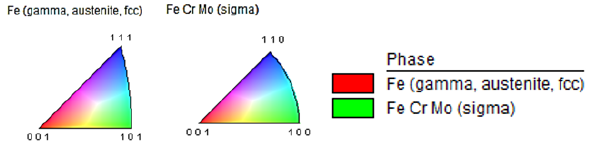
Figure 10. EBSD micrographs of 398 h crept specimen: ( a ) image quality, ( b ) inverse pole figure, and ( c ) phase map with grain boundary; and 9411 h crept specimen with σ phase: ( d ) image quality, ( e ) inverse pole figure, and ( f ) phase map with grain boundary.